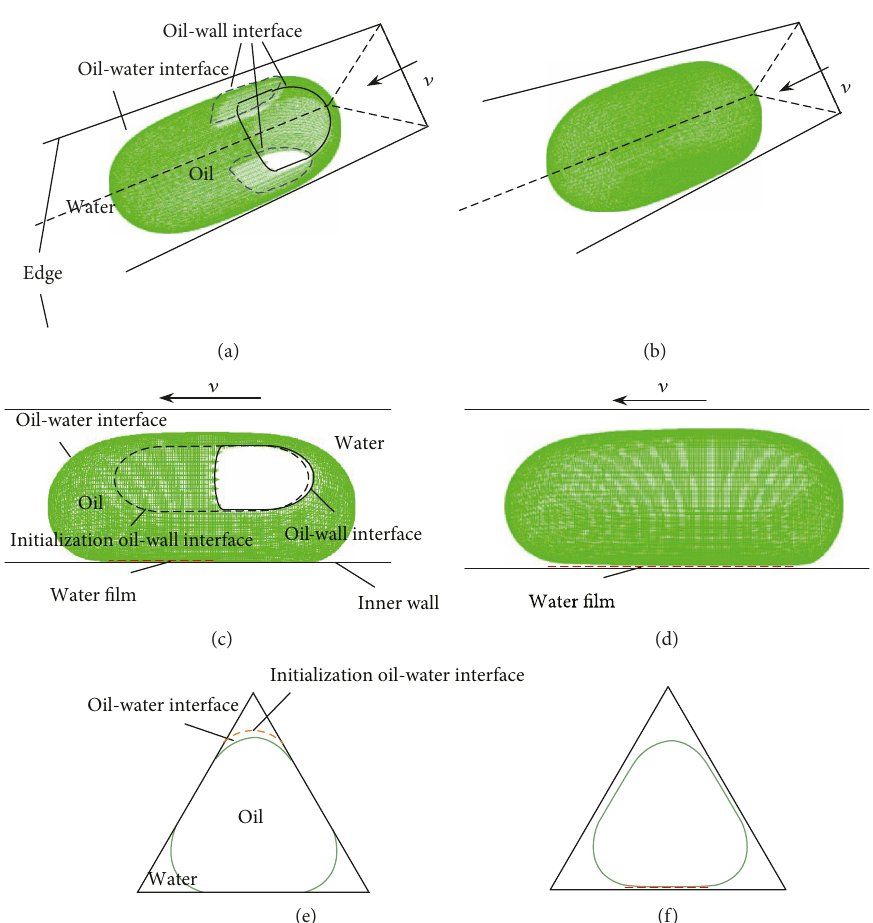
Figure 5: The oil-water interfaces in an equilateral triangle cross-sectional capillary: (a) three-dimensional view of the nonstart condition, (b) three-dimensional view of the start condition, (c) side view of the nonstart condition, (d) side view of the start condition, (e) cross-sectional view of the nonstart condition, and (f) cross-sectional view of the start